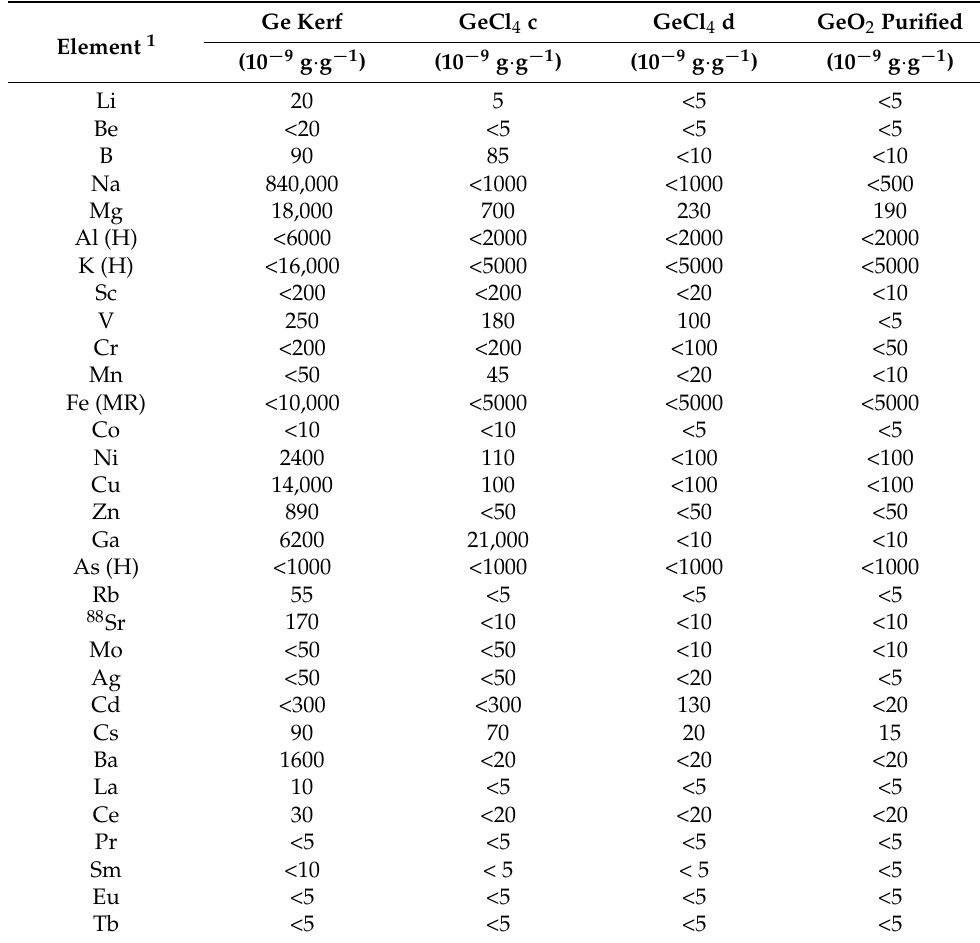
Table 6. Contamination levels for each sample reported as 10 − 9 g · g − 1 . The uncertainty is ± 30% of the given